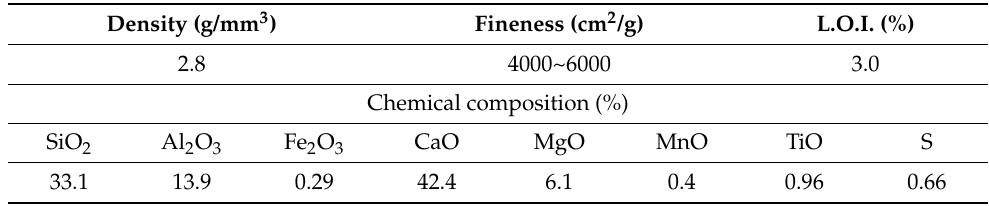
Table 3. Physical and chemical properties of the blast-furnace slag